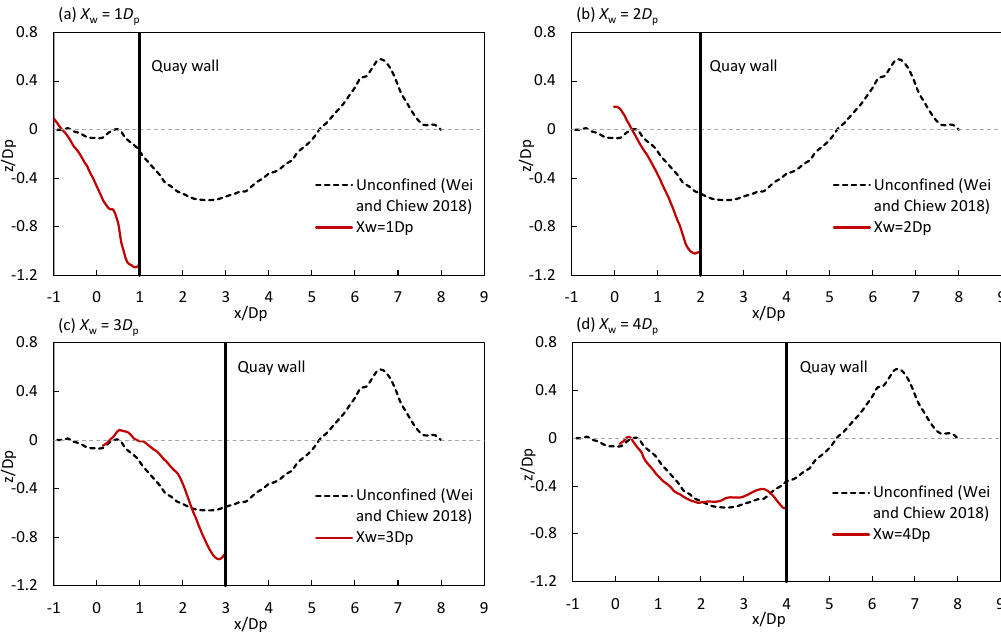
Figure 3. Comparison of asymptotic scour profiles between unconfined and confined cases: ( a ) X w = 1 D p ; ( b ) X w = 2 D p ; ( c ) X w = 3 D p ; ( d ) X w = 4 D p.